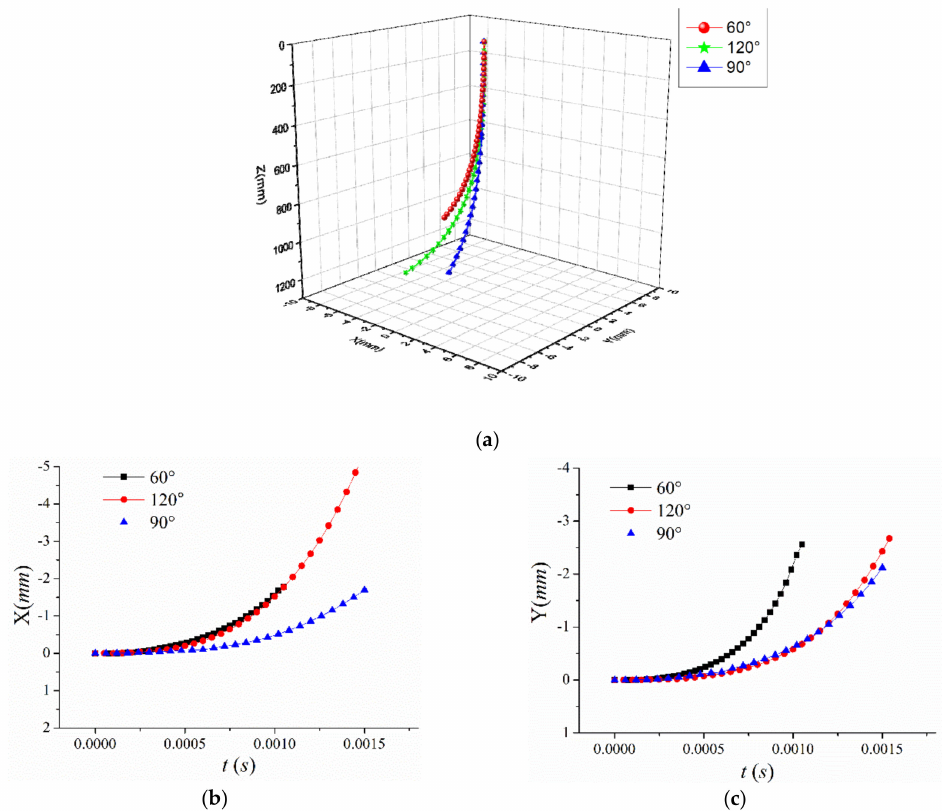
Figure 14. Centroid trajectory of projectile with di ff erent α : ( a ) 3D centroid trajectory; ( b ) Centroid deflection along X direction; ( c ) Centroid deflection along Y